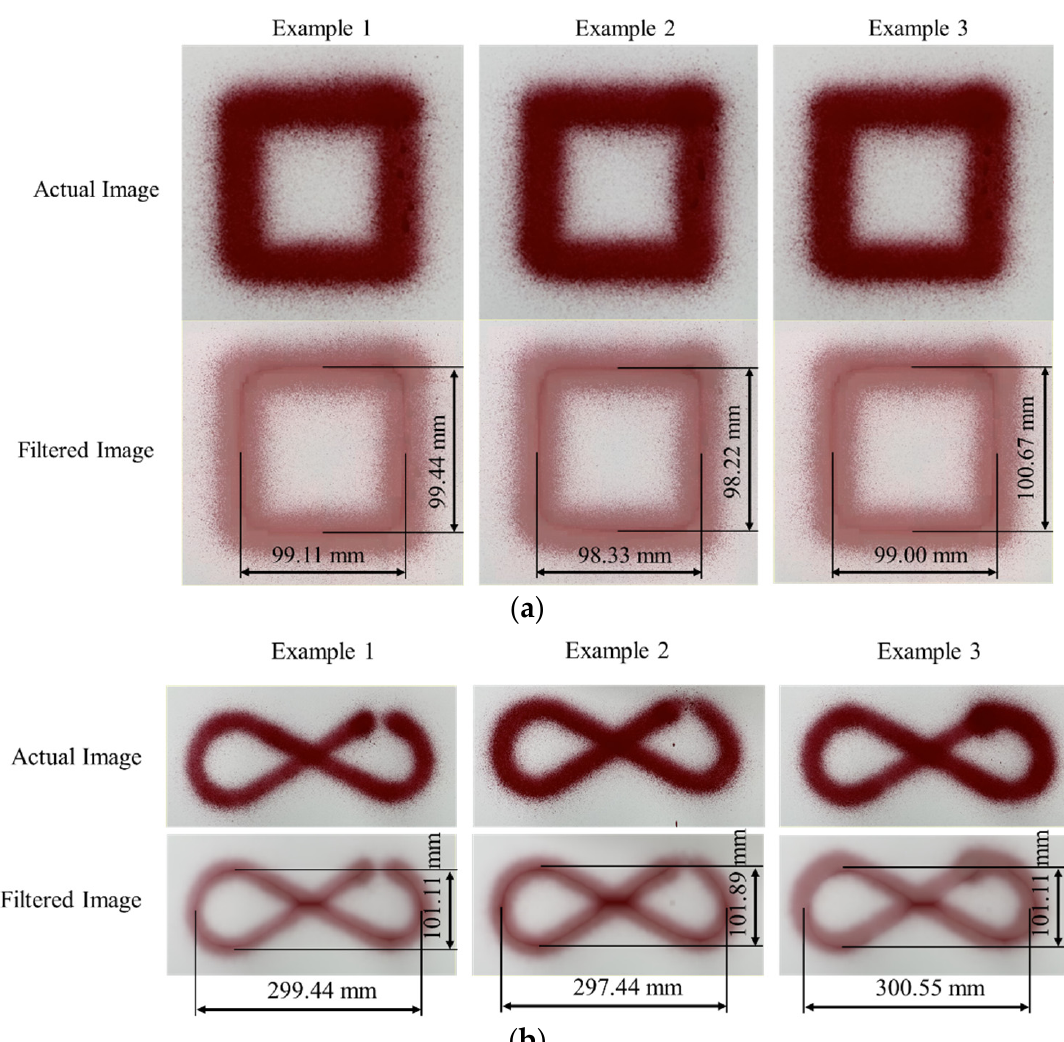
Figure 9. Examples of the Patterns: ( a ) Square Shape and ( b ) Infinity Symbol. The sizes of the designed square shape and infinity symbol patterns are 100 × 100 and 300 × 100 mm 2 , respectively. The images of square shape and infinity symbol painting were used to create a variation model that can be used for image comparison by MVTec Halcon 20.11. The mean and various images of the images were generated and are shown in Figure 10. Because the mean images in Figure 10a,b have the same shape and size as the designed square shape and infinity symbol patterns, each painting line of square shape and infinity symbol is almost coincident. Moreover, the black in the variation image presents the area that has a small variation of the object position in the image, and the white inside it presents the area that has a large variation of the object position in the image. The variation image in Figure 10 shows that the black area forms the same shape as the designed square shape and infinity symbol patterns and the white area is around the square shape and infinity symbol patterns, meaning that the painting system has good repeatability. Further, the root mean square errors (RMSEs) of the square shape and infinity symbol patterns are listed in Table